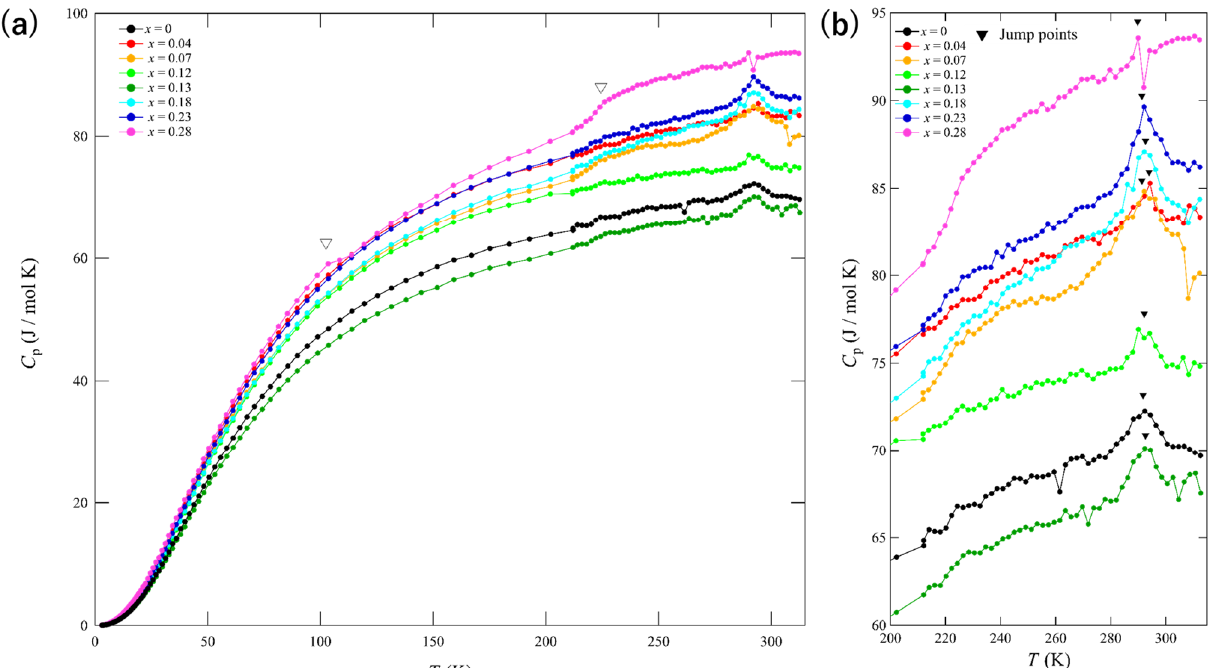
Figure 7. Temperature dependence of the specific heat ( C p ) for single crystals. ( a ) in the operating temperature range and ( b ) in the temperature range of 200–310 K. Open triangles indicate unknown small jumps. Solid triangles in ( b ) indicate C p jumps related to structural transitions.